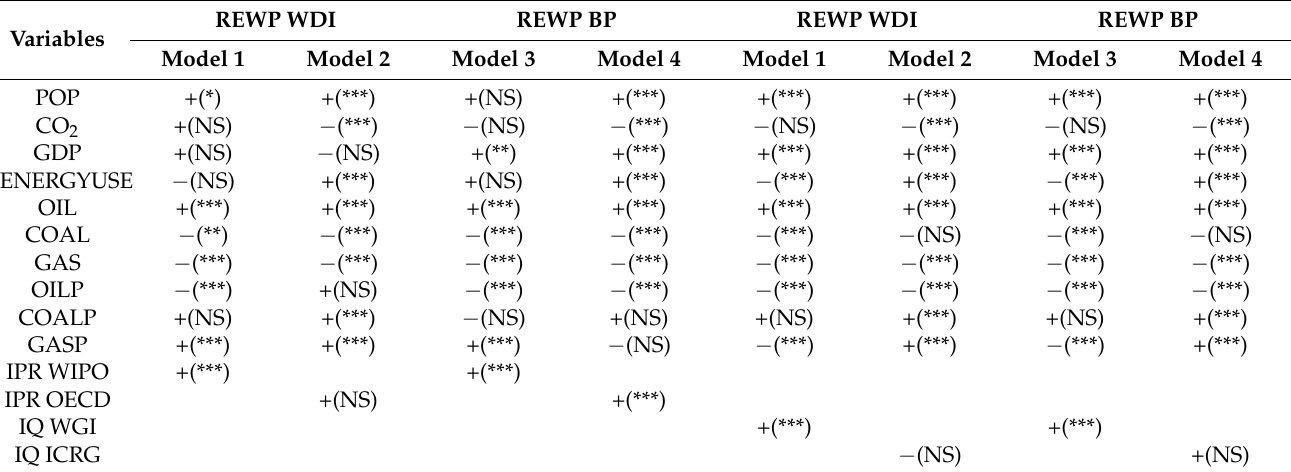
Table 4. Summary of results of intellectual property right and institutional